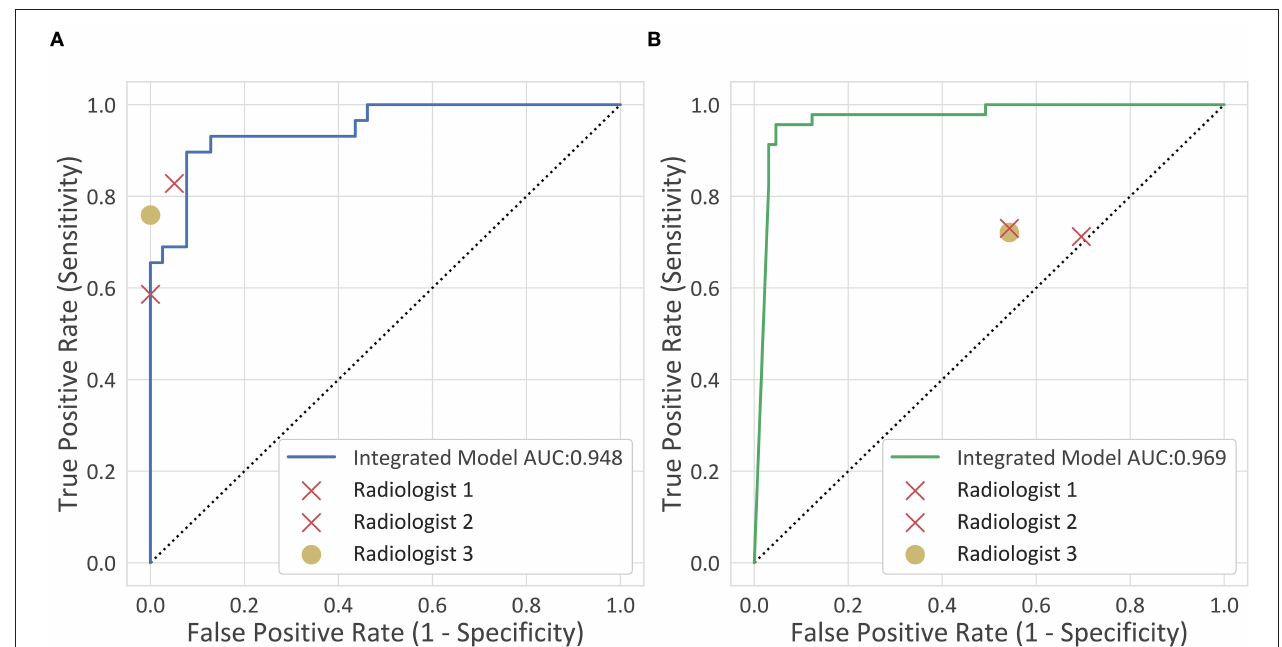
FIGURE 5 | Clinical comparison. The diagnostic performance of the deep-integrated model and the three observers are shown. (A) The internal testing cohort. (B) The external testing